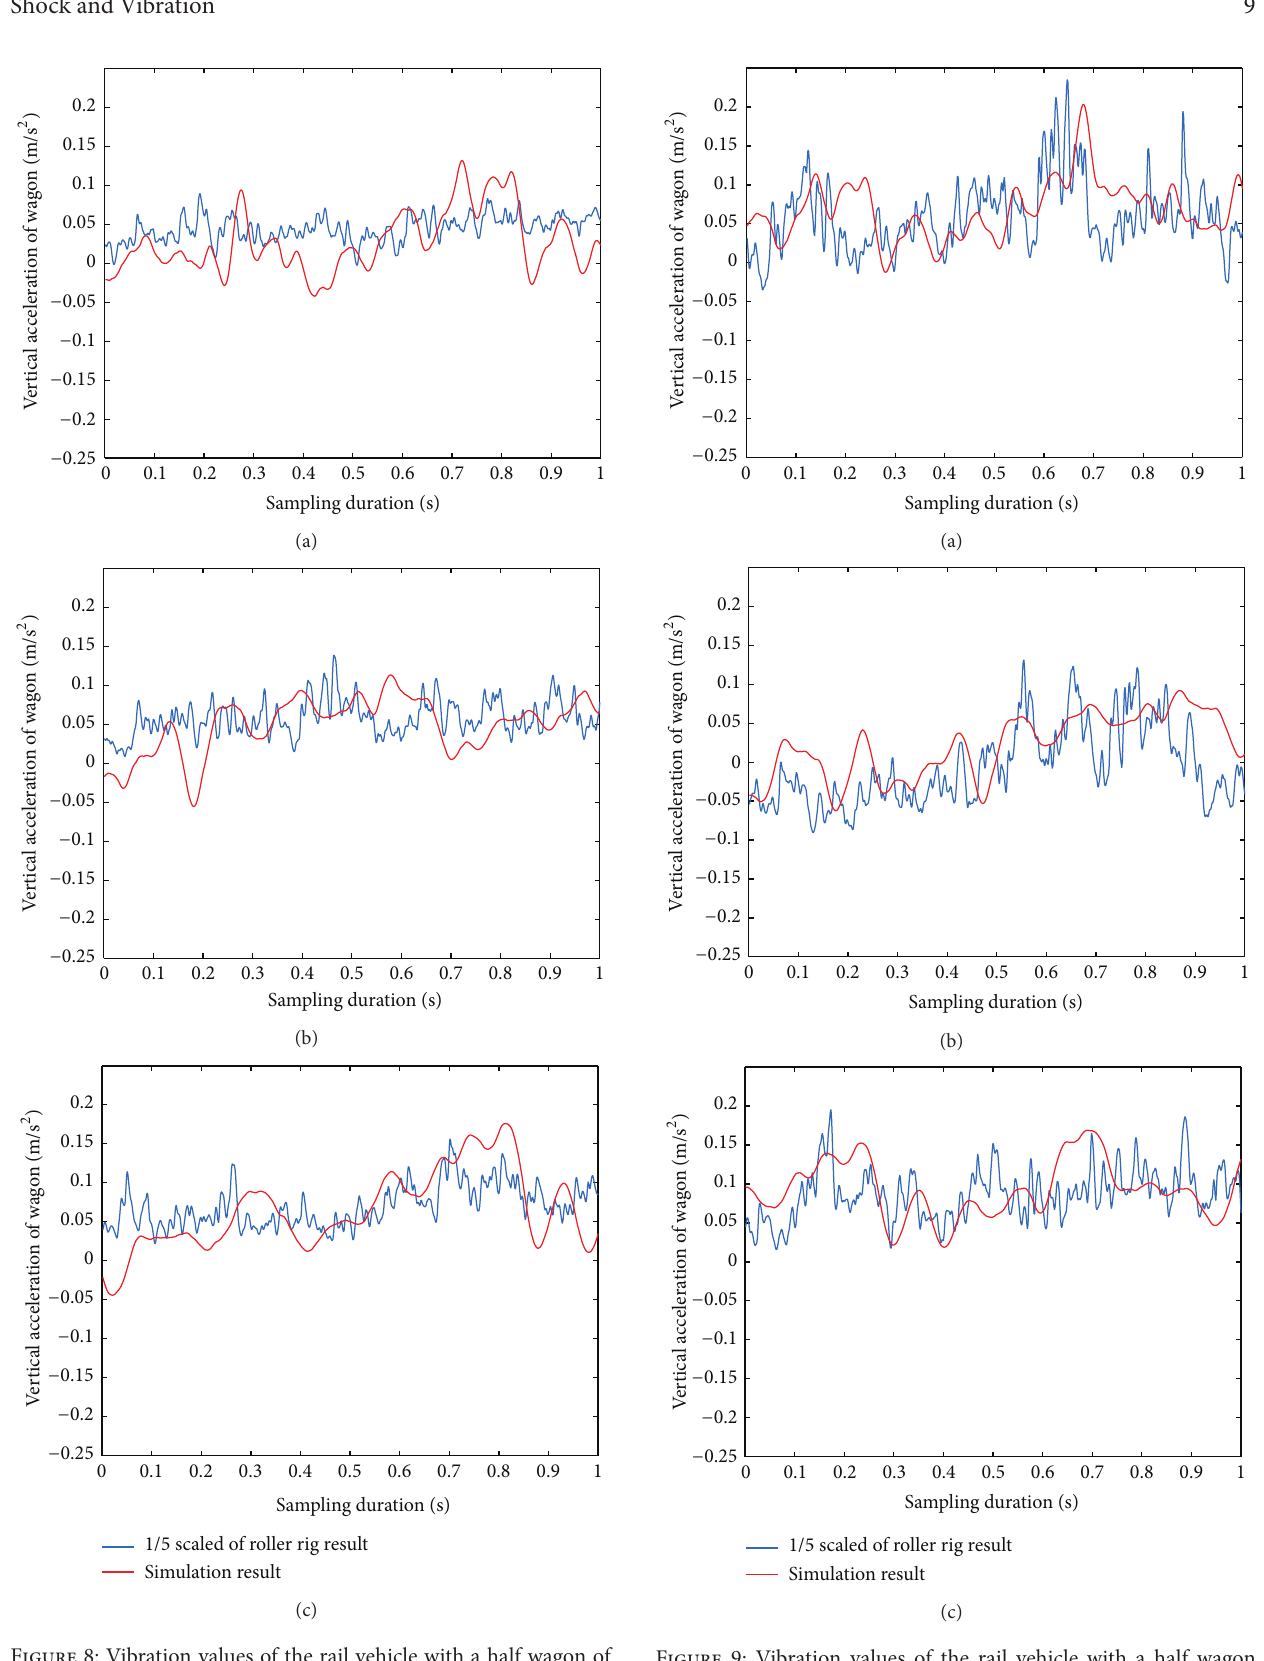
Figure 9: Vibration values of the rail vehicle with a half wagon of 25 tons moving in the horizontal plane on the bridge with an acceleration of 0.49 m/s 2 and with a velocity of (a) 150 km/h, (b) 200 km/h, and (c) 250